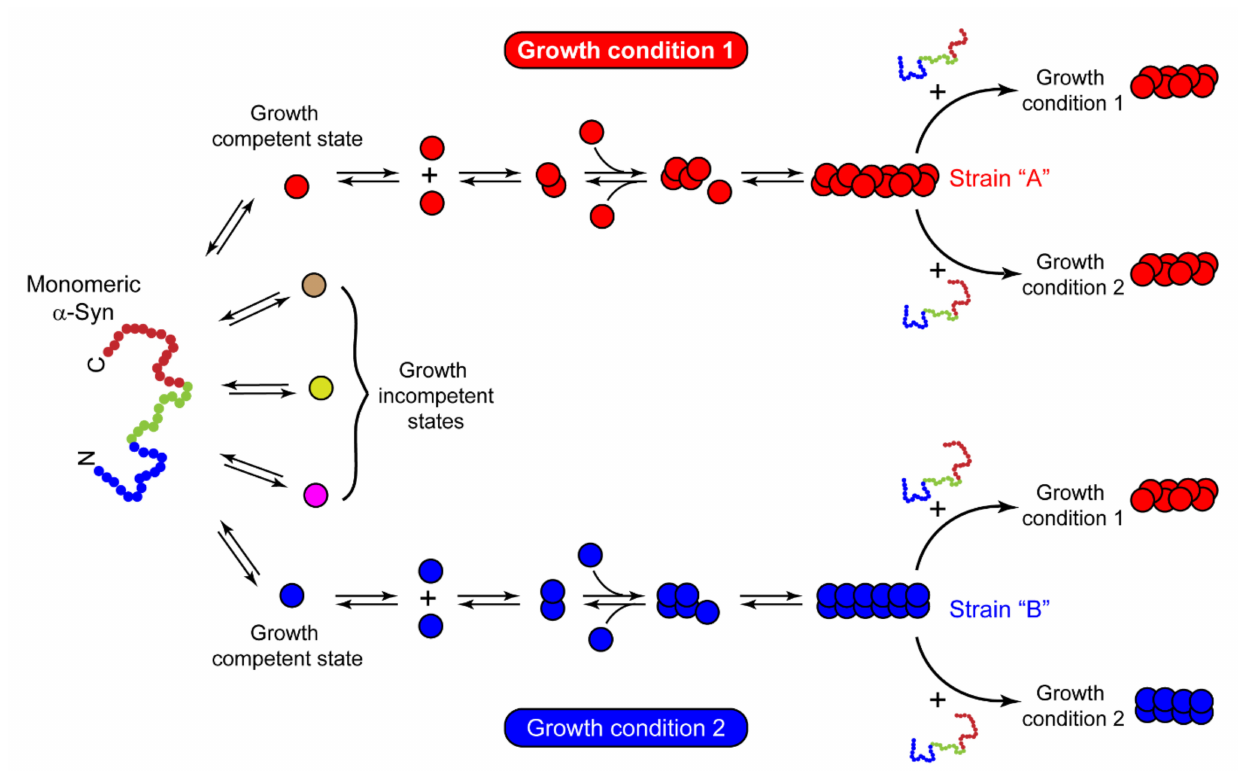
Figure 3. Mechanism of strain formation and its propagation. Natively unstructured monomeric α -Syn populates into multiple conformational states with distinct abilities to form amyloid fibrils. Red and blue circles represent the growth- competent states, which, under certain sets of growth conditions 1 and 2, form different fibril strains ‘A’ and ‘B’, respectively. Strain ‘A’ seeds the monomeric protein and passes on its structural architecture to the next generation of fibrils, irrespective of growth condition 1 or 2. In contrast, strain ‘B’ passes its structural characteristics on the daughter fibrils only in the same assembly conditions that were used for its growth (growth condition 2). This suggests that the nature of seeds and growth conditions play an essential role in deciding the fate of assemblies upon cross-seeding. The other conformations in brown, yellow, and pink circles cannot yield thermodynamically stable intermolecular interactions and are incapable of growth. These are referred to as growth-incompetent